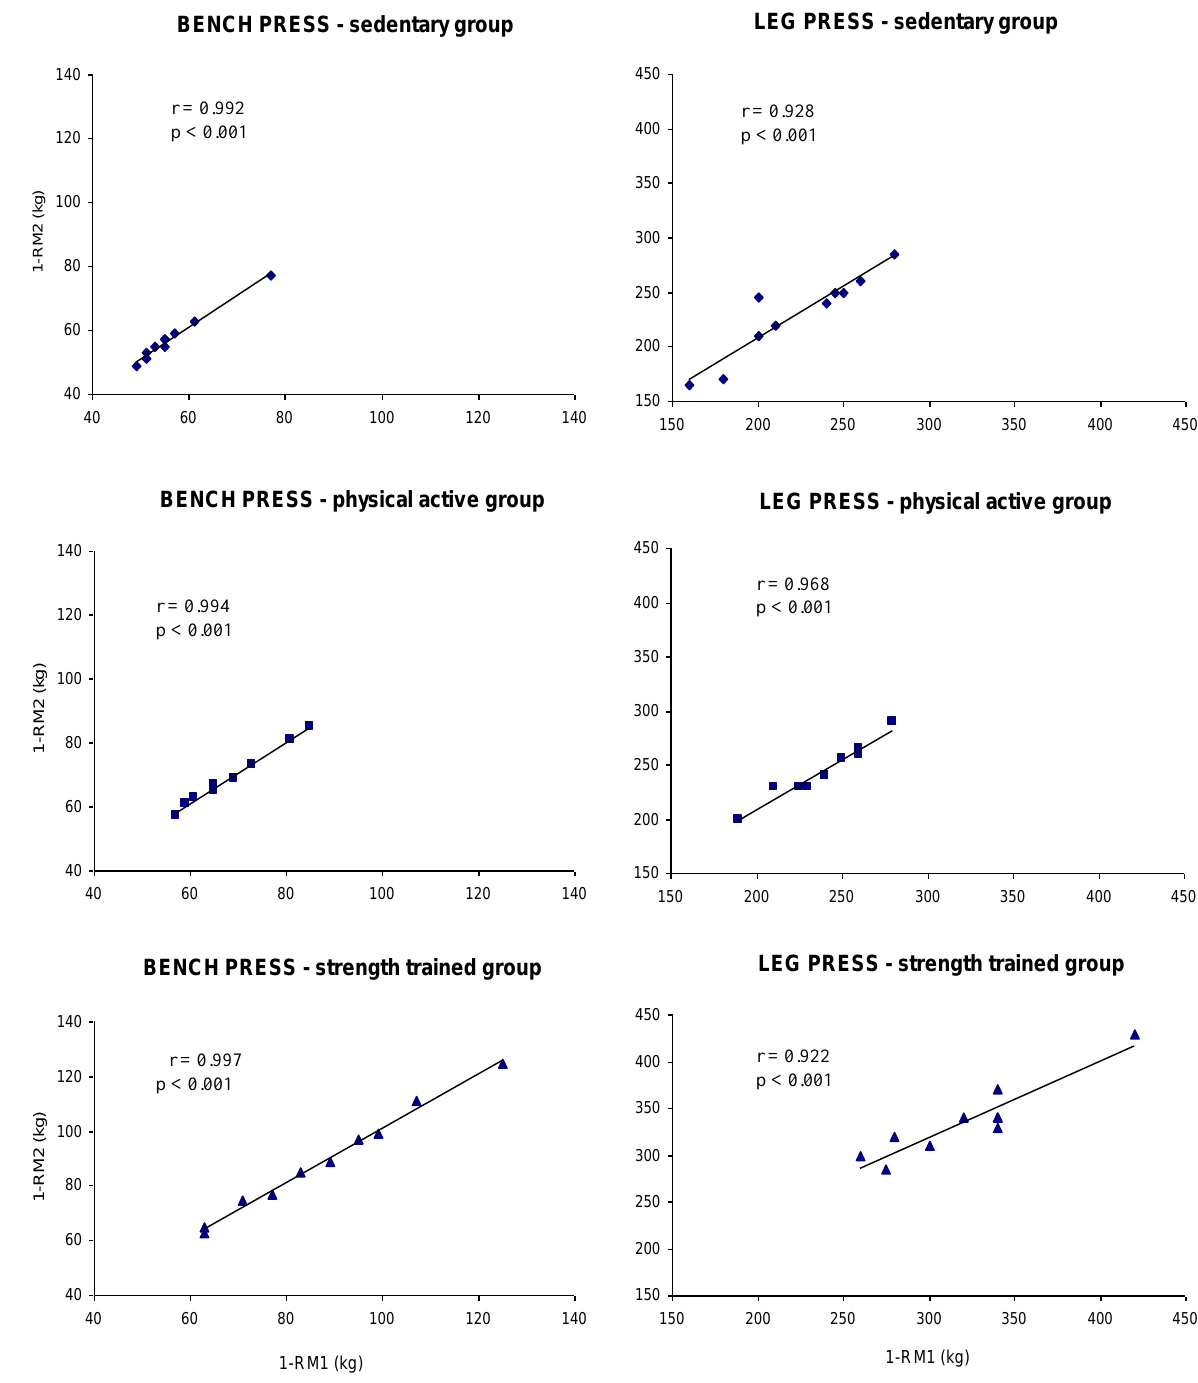
Figure 2. Intraclass correlation coefficients (r) between 1-RM1 e 1-RM2 (kg) tests in sedentary, physical active and strength-trained groups for bench press and leg press